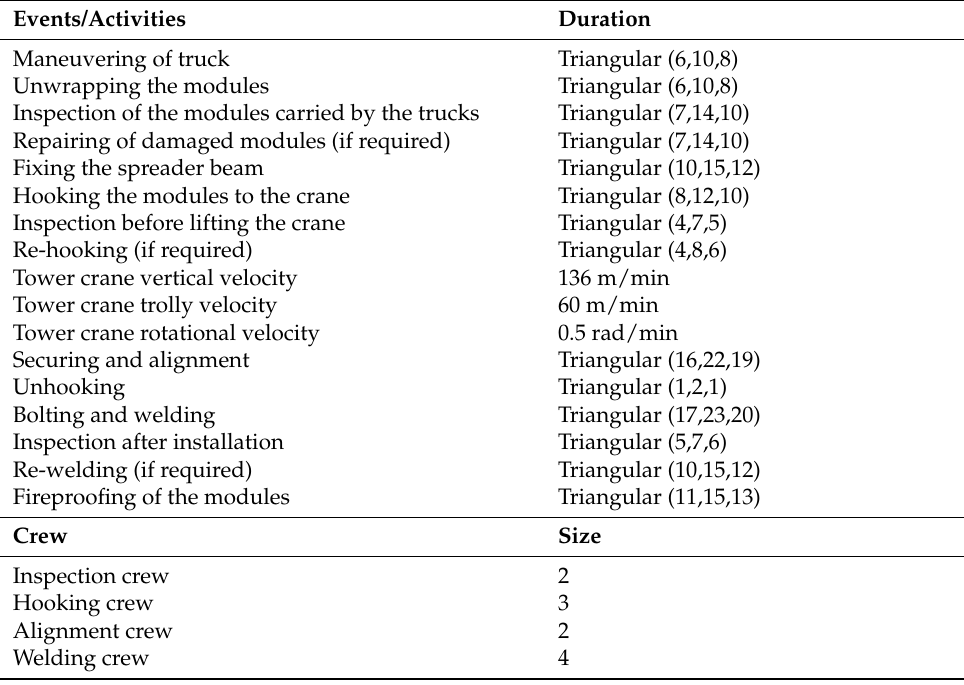
Table 2. Collected data for MiC installation activities.